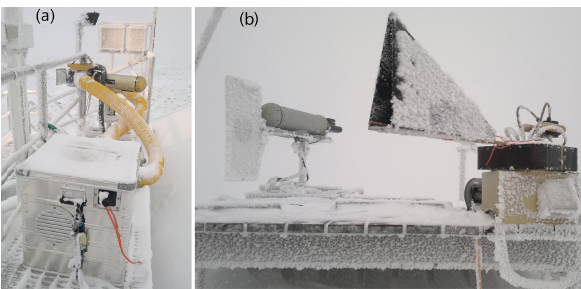
Figure 1. (a) The CAPS probe setup and (b) the FSSP-100 and the CDP setups as they were installed on Sammaltunturi station during PACE